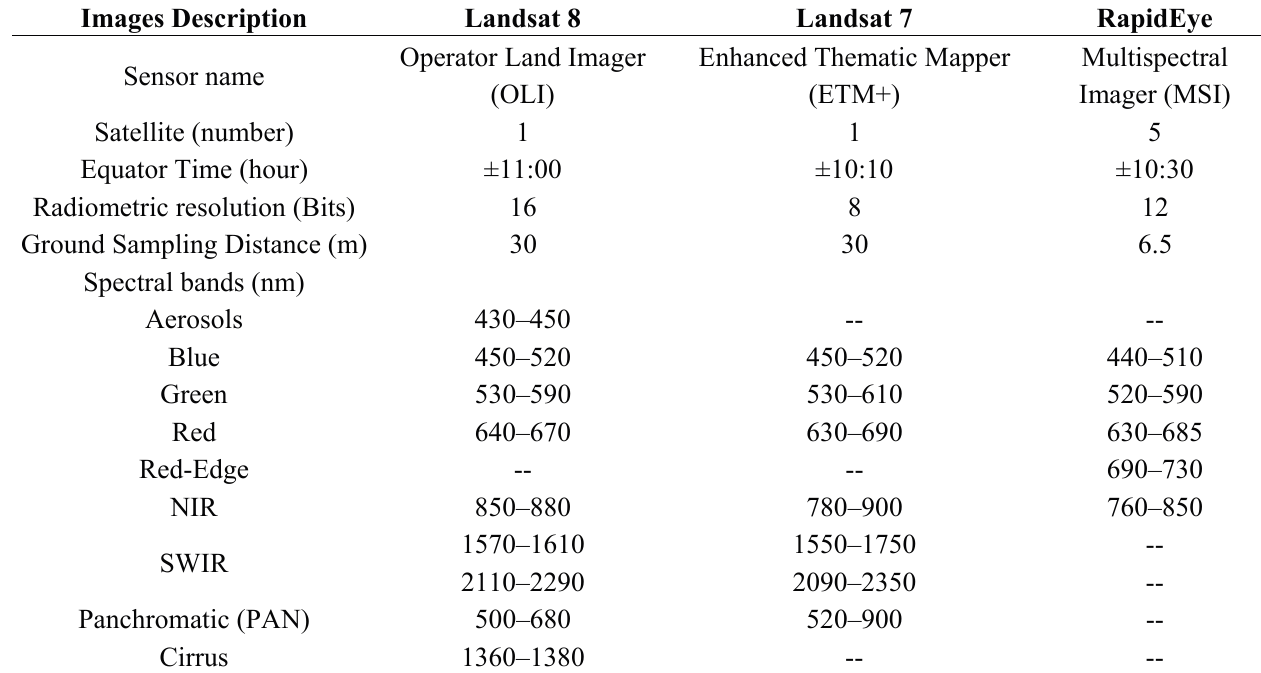
Table 1. Basic characteristics of Landsat 8 and 7 Operational Land Imager (OLI) and Enhanced Thematic Mapper Plus (ETM+) and